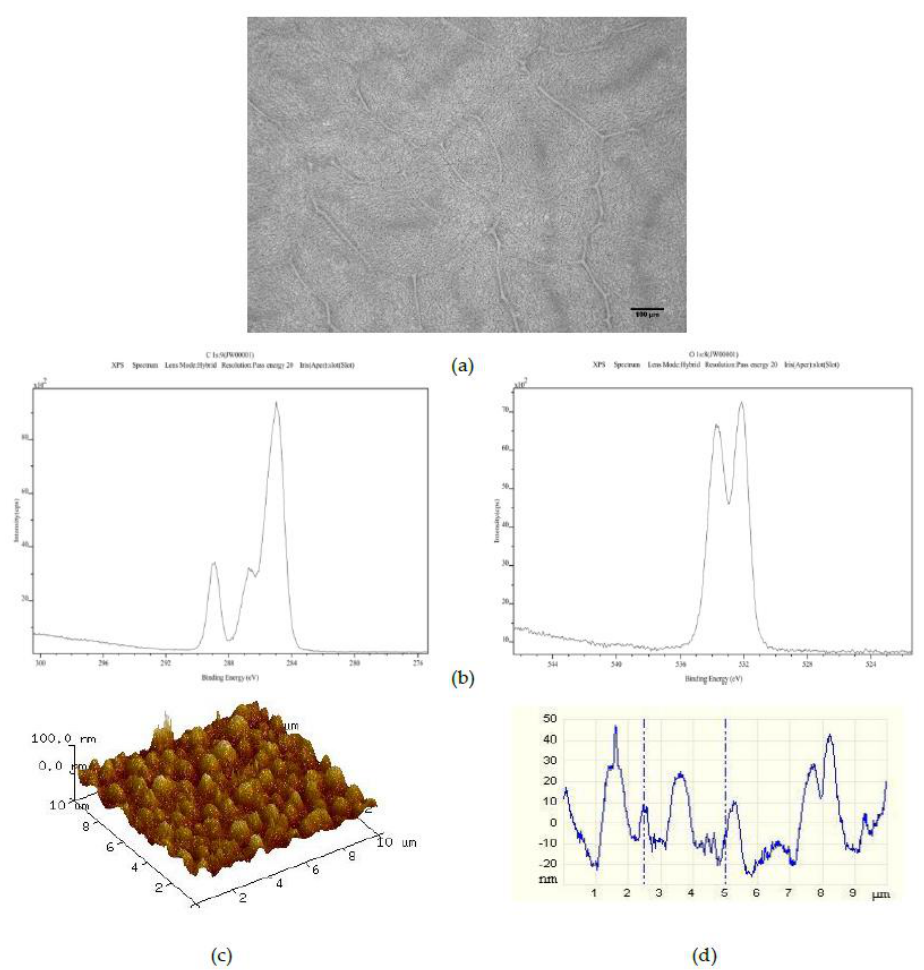
Figure 4. Characterisation of 25PS/75PMMA + 1500 films by ( a ) optical microscopy (×20); ( b ) C1s ( right ) and O1s ( left ) XPS spectra; ( c ) AFM 3D plots and ( d ) AFM line profile. Table 3. Average % surface coverage ( n = 5) and standard deviation values for 25PS/75PMMA spin coated surfaces with and without addition of 750 and 1500 50 μm PS microspheres.